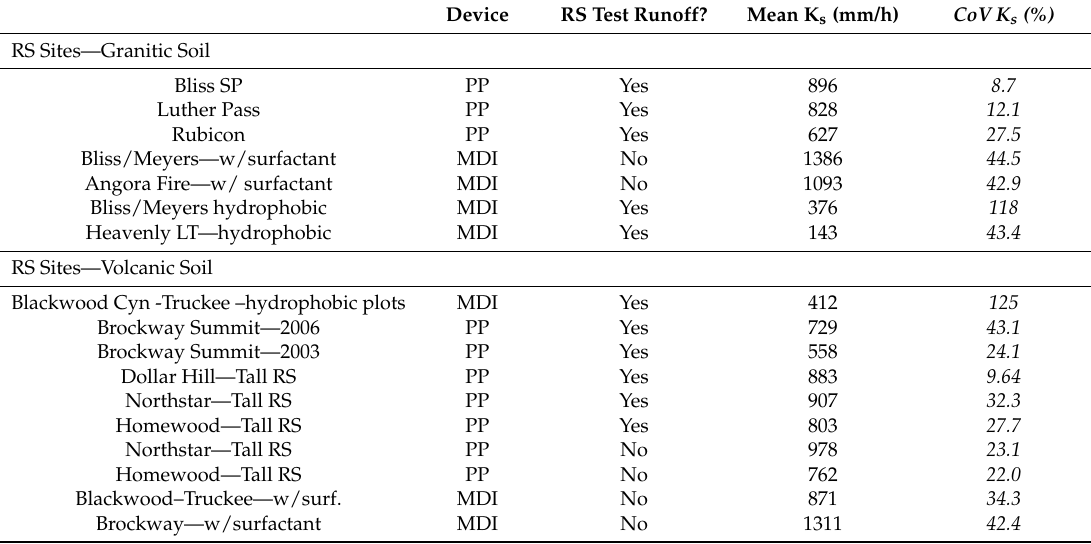
Table 8. Summary of hydraulic conductivity measurements associated with RS